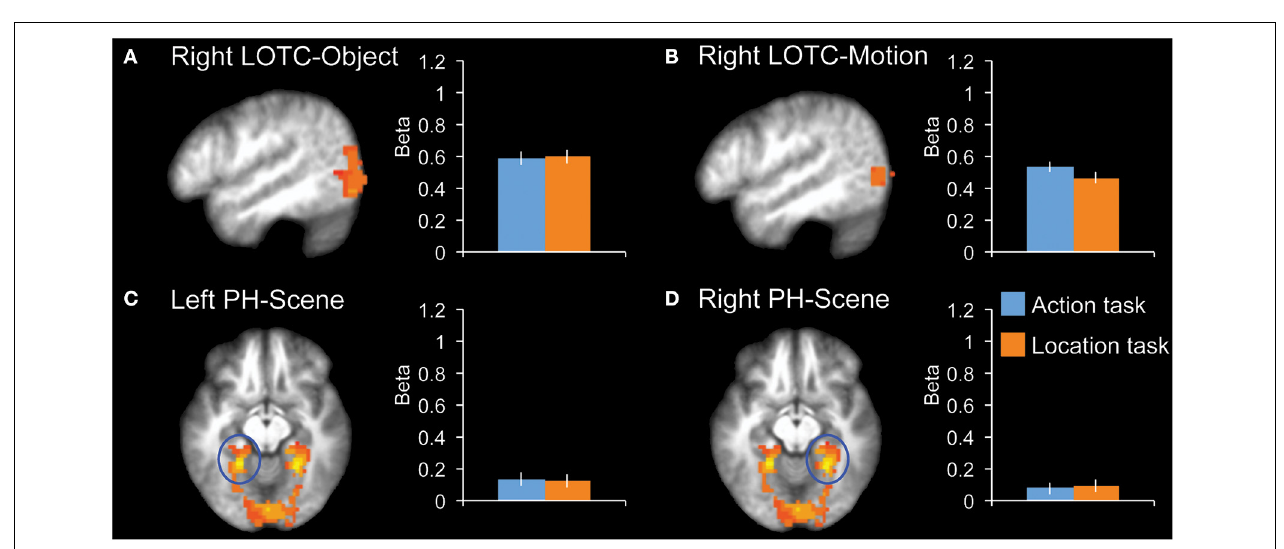
( z = − 18), (B) Right FG-Tool ( z = − 18), (C) left LOTC-Tool ( x = − 46), (D) Left IPS-Tool ( z = 42). All brain activity maps are shown at P < 0 . 005, displayed on the group-average anatomical scan. Error bars reflect within-subject s.e.m.